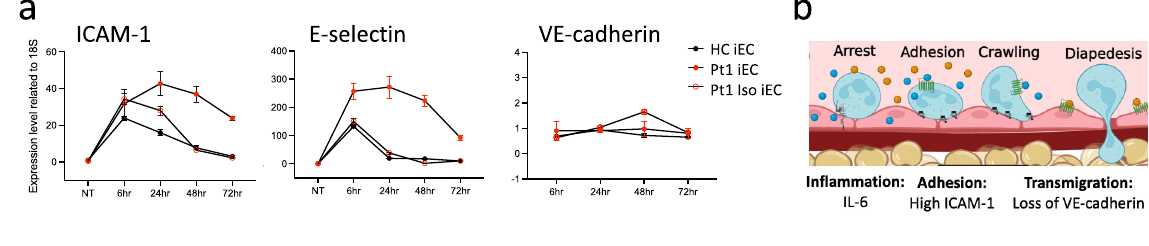
independentexperiments.Scatterplotgraphony-axisindicatesfold-changeofthe adhered neutrophilcountsto HCiECand HCneutrophilco-culturecounts.Mean± SEM of 3 technical replicates from 3 separate experiments are depicted. * p <0.05, ** p =0.01, as determined by two-way ANOVA test. Scale bars, 50 μ m. d Neutrophil transendothelial migration (TEM) is quanti fi ed after 24h in an endothelial cell transwell migration assay. Data are presented as mean ± SEM from biological replicates of: HC iEC ( n =4), Pt1 iEC ( n =5), Pt1 iso iEC ( n =3), neutrophils only representsfold-changeofthemigratedneutrophilcountscomparedtoPt1iECand HC neutrophil co-culture counts. Mean ± SEM from 5 biological replicates